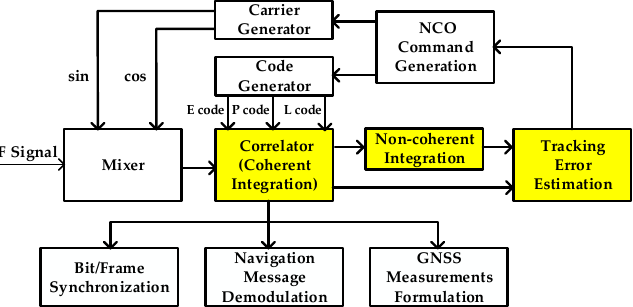
Figure 1. Baseband signal processing flow of GNSS receivers. IF: intermediate frequency; NCO: numerically-controlled oscillator.